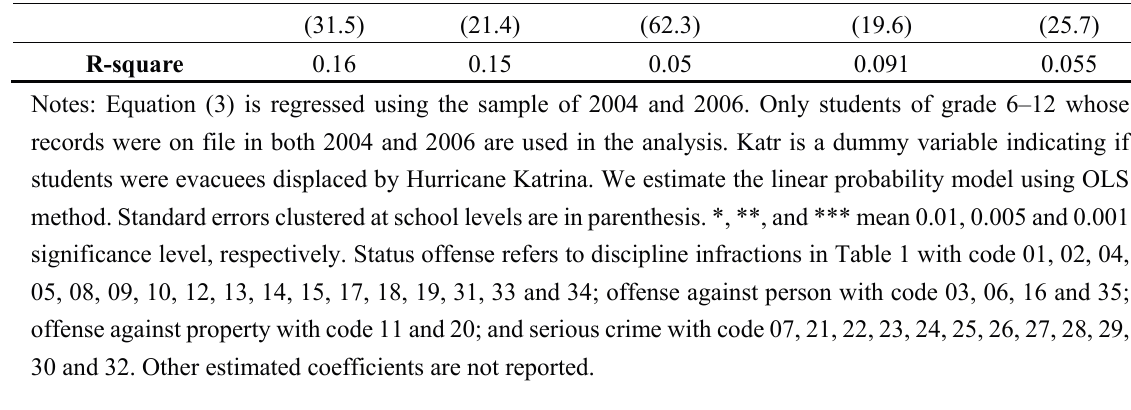
Table 6. Effect of Hurricane Katrina on displaced students’ likelihood of discipline infraction (Only students with grade 6–12 are used in the analysis, N = 617,896). Dependent Variable Independent Dummy for Dummy for Dummy for Dummy for Dummy for Variable any Status Offense against Offense against Serious Infraction Offense Person Property Crime Katr − 0.0016 − 0.0047 − 0.0031 − 0.0021 − 0.003 (0.0707) (0.0064) (0.0045) (0.0053) (0.005) PostKatr * 0.087 *** 0.057 *** 0.012 *** 0.049 *** 0.025 *** (0.003) (0.002) (0.002) (0.003) (0.003) Post 0.98 0.54 1.15 (31.5) (21.4) (62.3) (19.6) (25.7) R-square 0.16 0.15 0.05 0.091